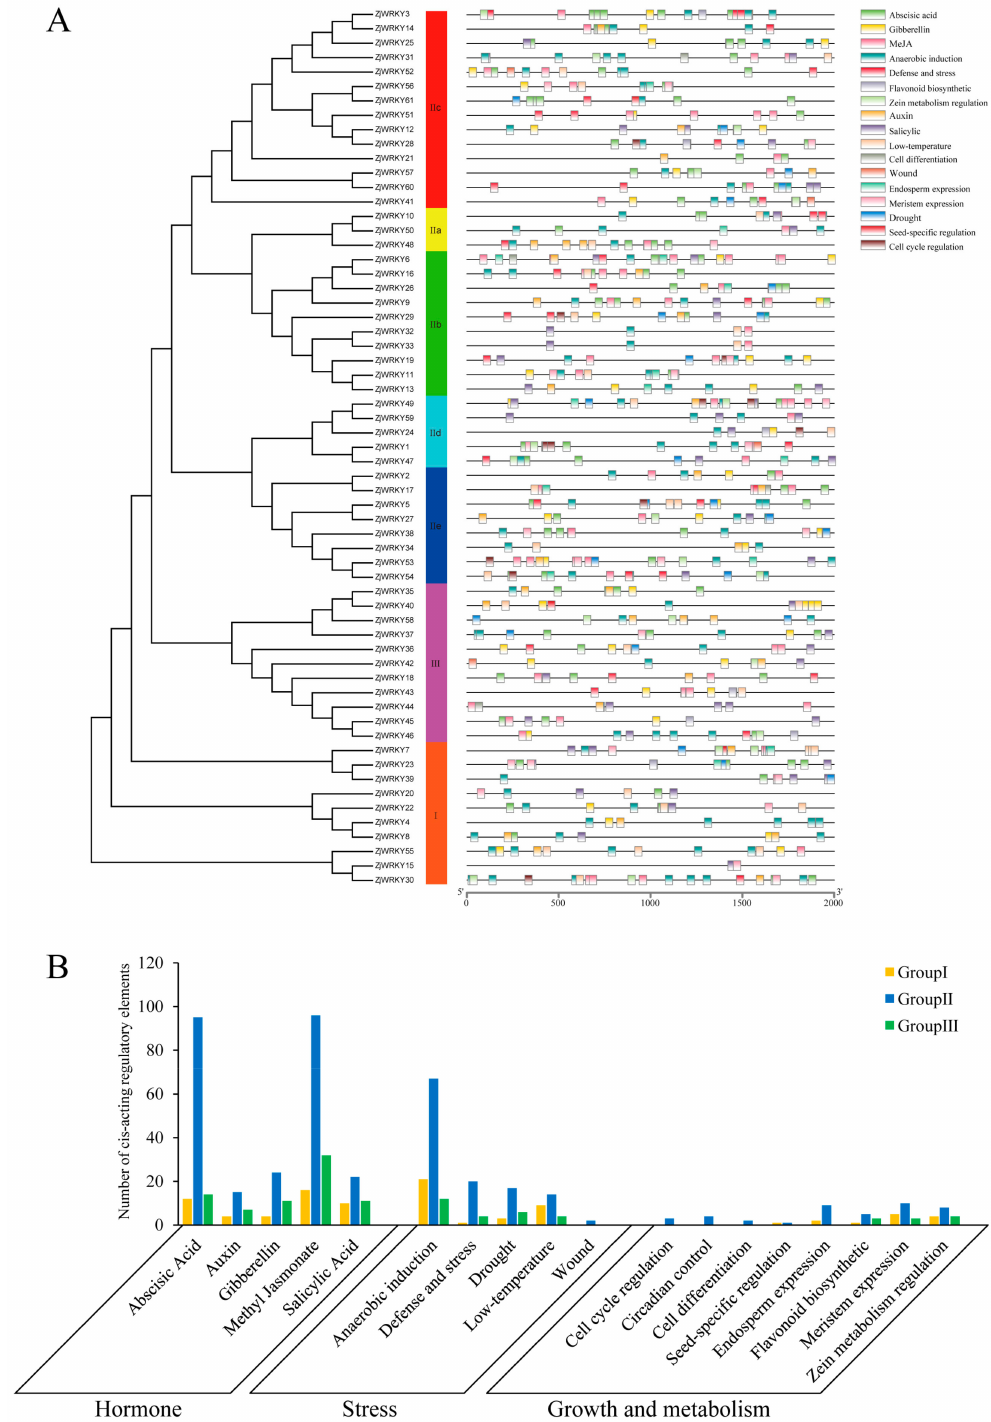
Figure 5. Type and number of cis -acting regulatory elements in the promoter region of WRKY genes of Ziziphus jujuba ‘Junzao’. ( A ) Position of the cis -acting elements in the ZjWRKY genes promoter region. ( B ) Number of cis -acting